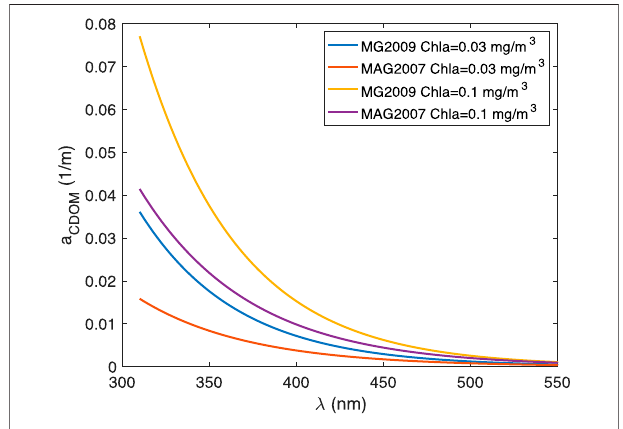
FIGURE 2 | The absorption coef fi cient of CDOM as a function of wavelengthfortwo[Chla]values:0.03 mg/m 3 and0.3 mg/m 3 Φ =1in Eq.8 is used in the fi